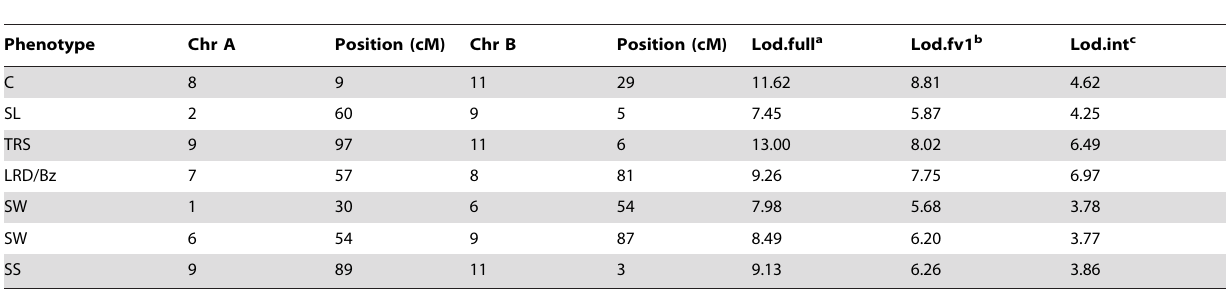
Table 4. Interaction LOD scores for phenotypes significant at the genome-wide level (P , 0.05).